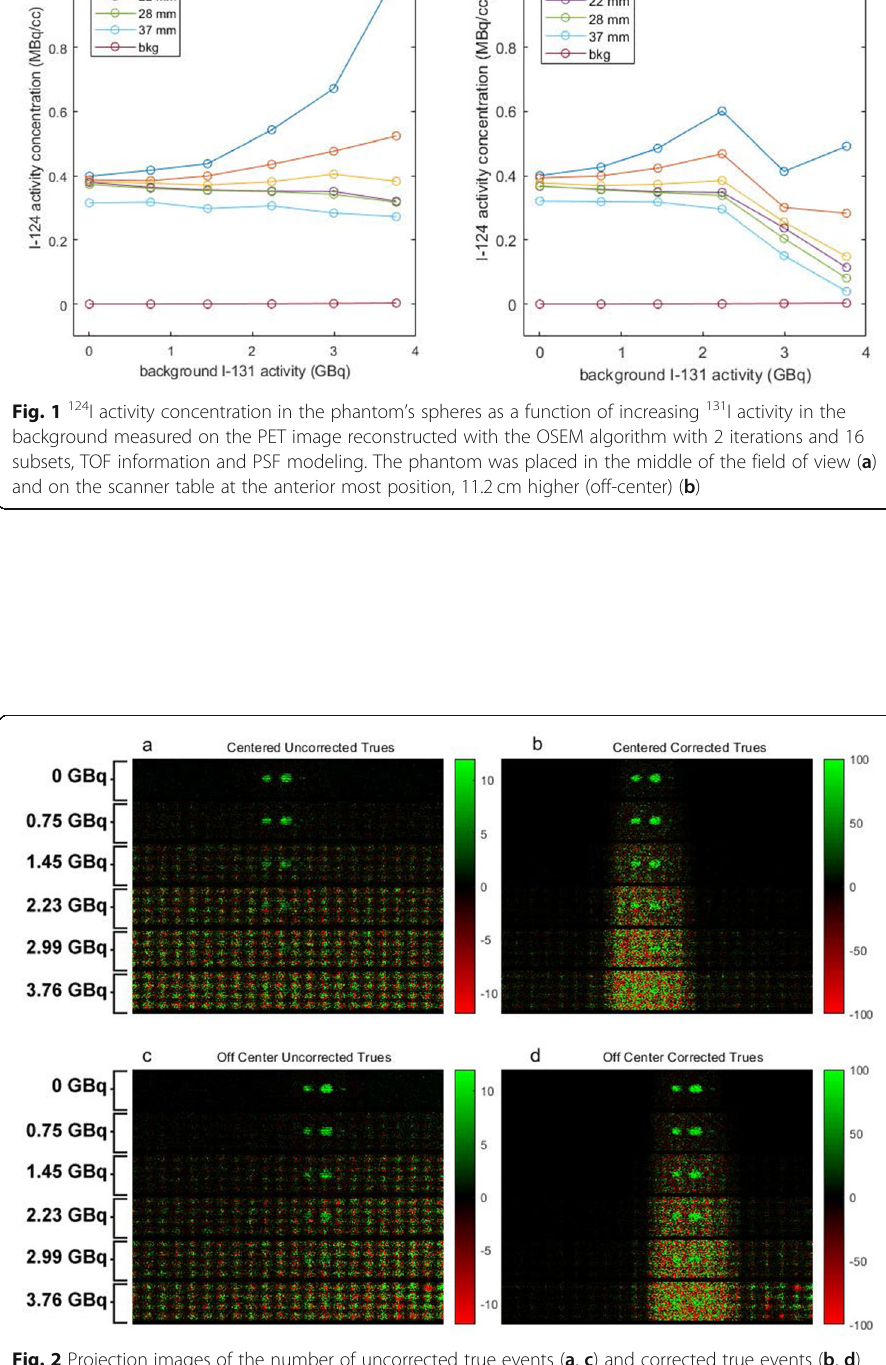
Fig. 2 Projection images of the number of uncorrected true events ( a , c ) and corrected true events ( b , d ) for the centered ( a , b ) and off-centered phantom ( c , d ) acquisition and for increasing 131 I activity in the background. The corrected number of trues corresponds to the number of trues recorded by the PET system multiplied by the dead-time correction factor, the normalization factor, and the attenuation correction factor